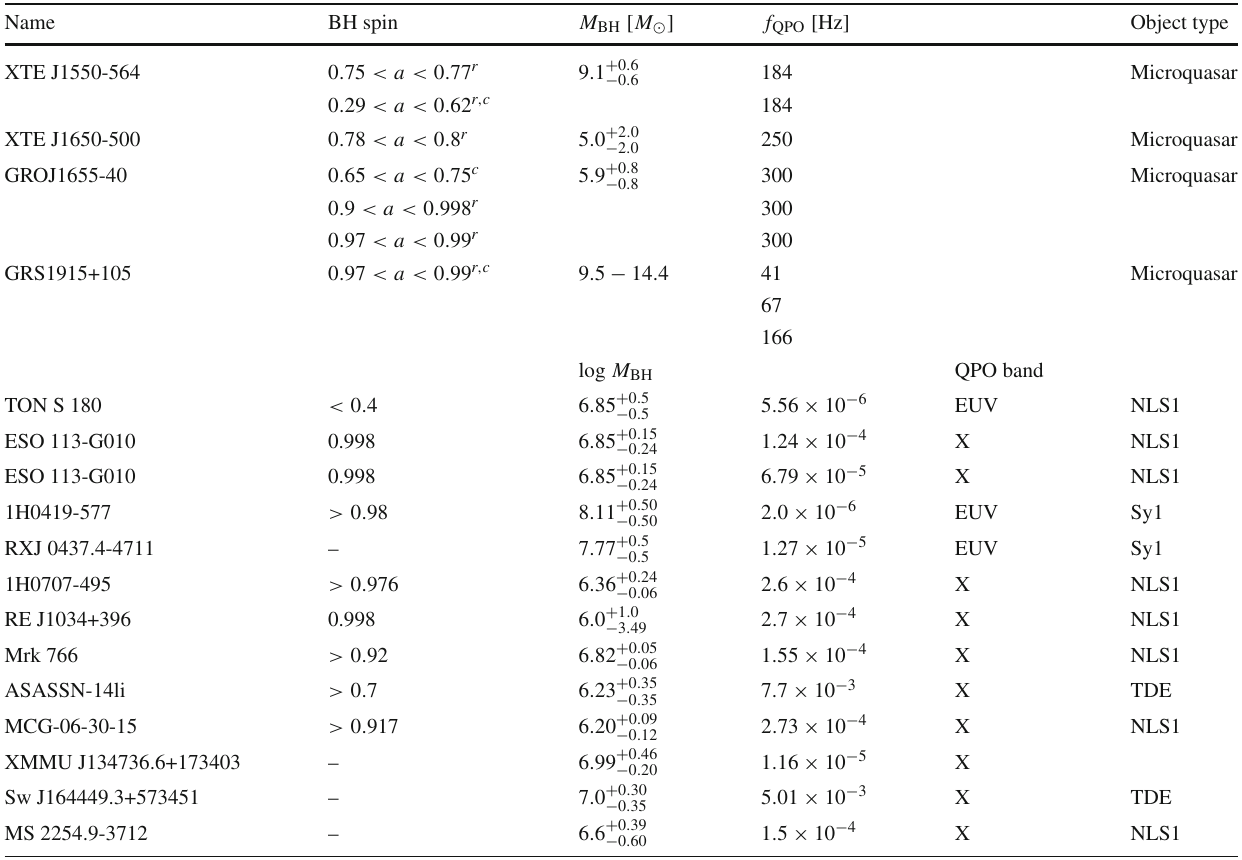
Table 1 Observational data for QPOs around stellarmass and super- massive BHs [31]. In objects where multiple HF QPOs are reported in small integer ratios, only the lowest frequency is given. Superscripts on the spin ranges indicate the measurement methods: Fe K α reflec- tion spectroscopy ( r ) or continuum fitting ( c ). Restrictions on mass and